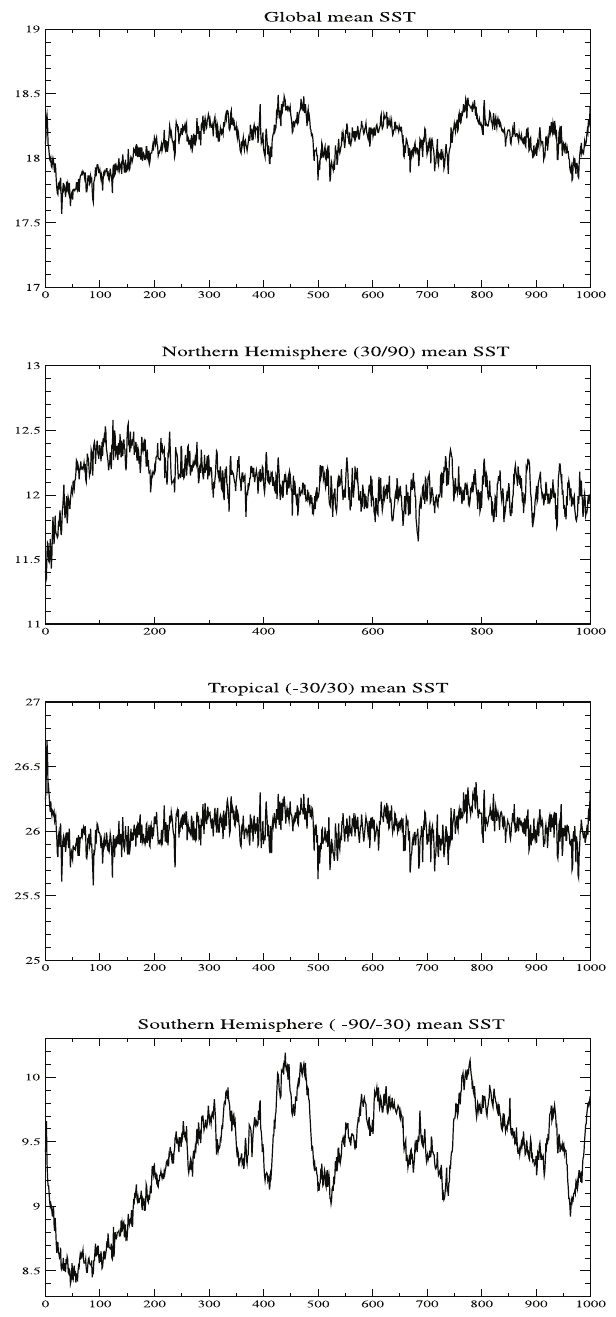
Fig. 1. Mean sea-surface temperature ( ° C) in function of simulated year for (from top to bottom ) the whole globe, the Northern Hemisphere (30/90 ° N), the tropics (30 ° S/30 ° N) and the Southern Hemisphere (30/90 °